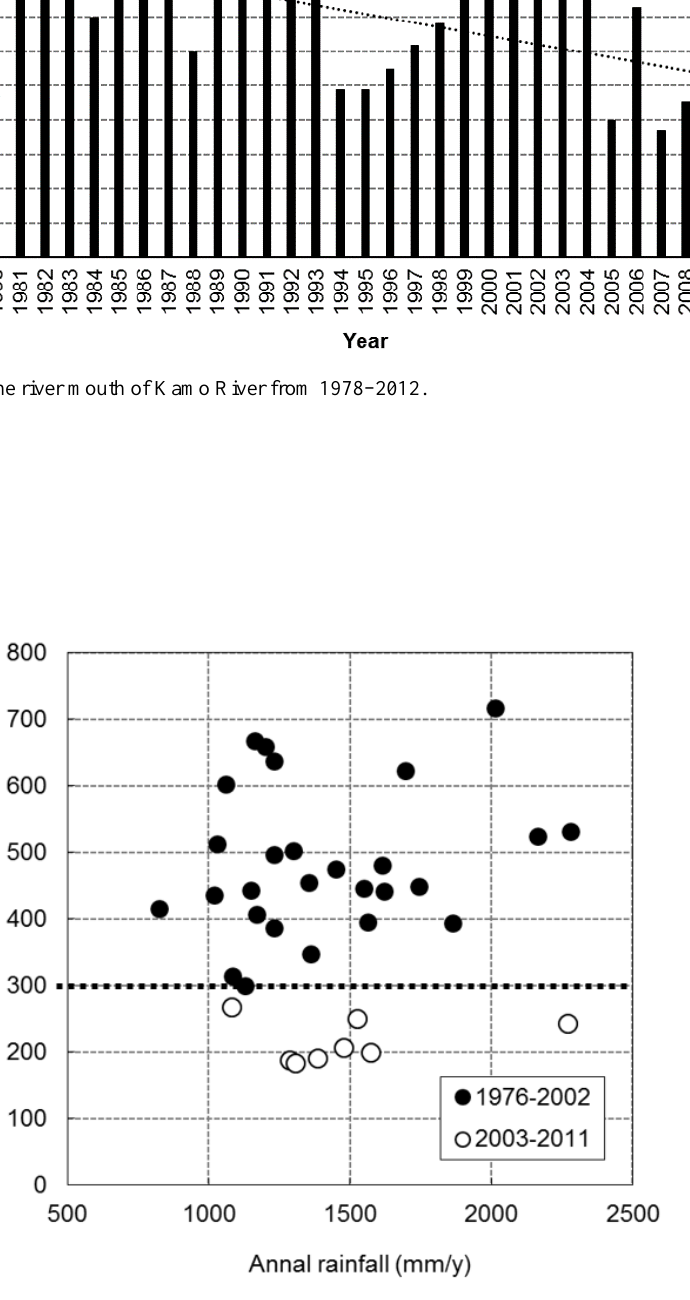
Figure 7. The relation between annual rainfall and seaweed